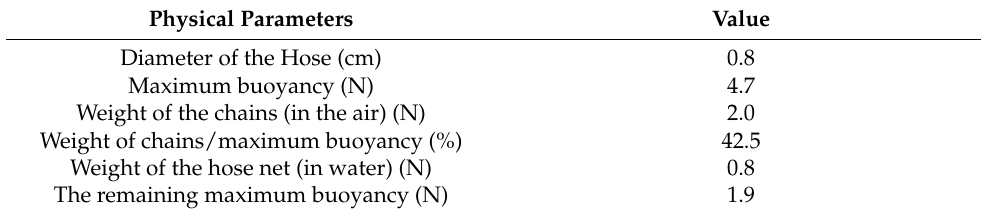
Table 3. Physical parameters of the 1/60 hose net used in catch-hauling tests.